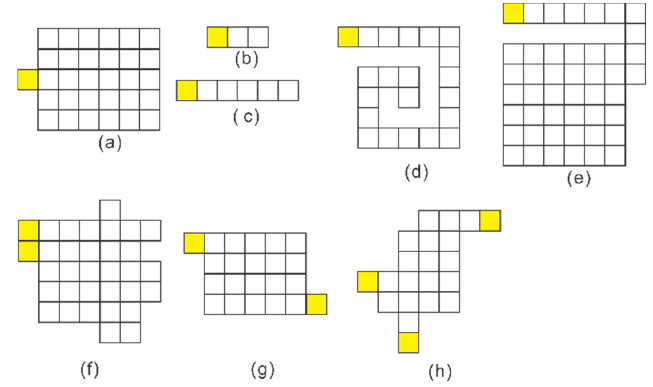
Figure 4. Topographic characteristics of different testing surfaces: ( a ) a normal single-threshold flat area; ( b - c ) linearly distributed flat areas; ( d ) spiral-shaped flat area; ( e ) combination of flats ( d ) and ( a ); ( f ) flat area with two adjacent thresholds; ( g ) rectangular flat area with two separated thresholds; and ( h ) irregular flat area with multiple thresholds.